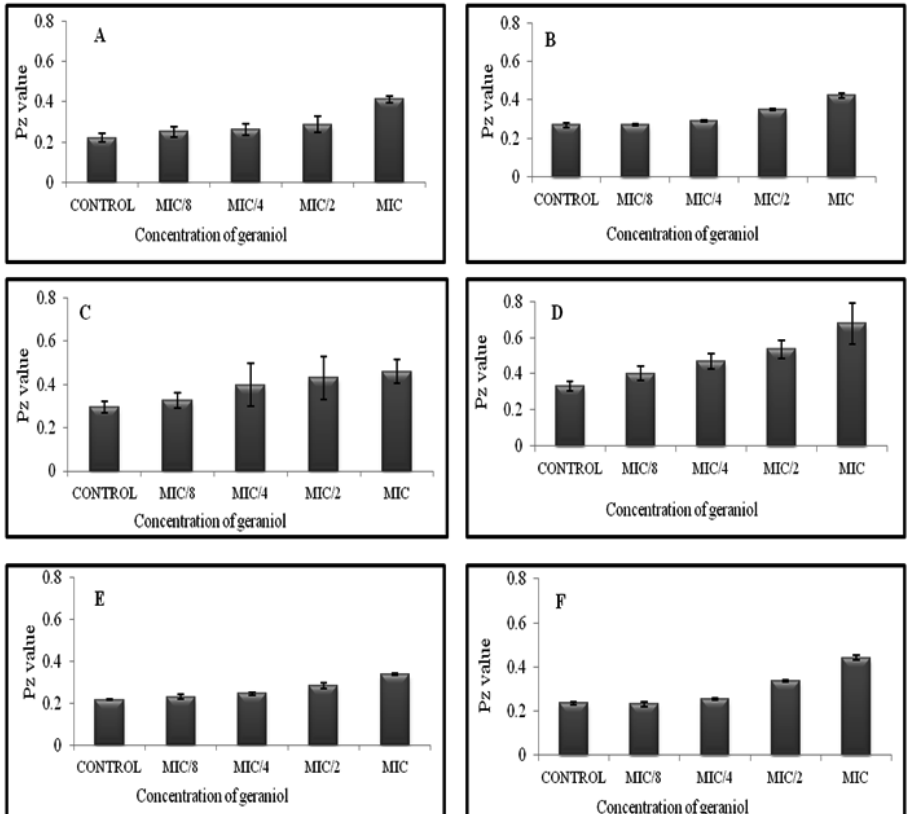
Fig. 4. (b). Effect of geraniol on proteinase secretion by C. albicans ATCC 90028 and 10261 (A and B), C. albicans D-27 (C) , C. albicans S-1 (D), C. glabrata ATCC 90030 (E), C. tropicalis ATCC 750 (F). Error bars represent ± SD to the mean value from 3 different